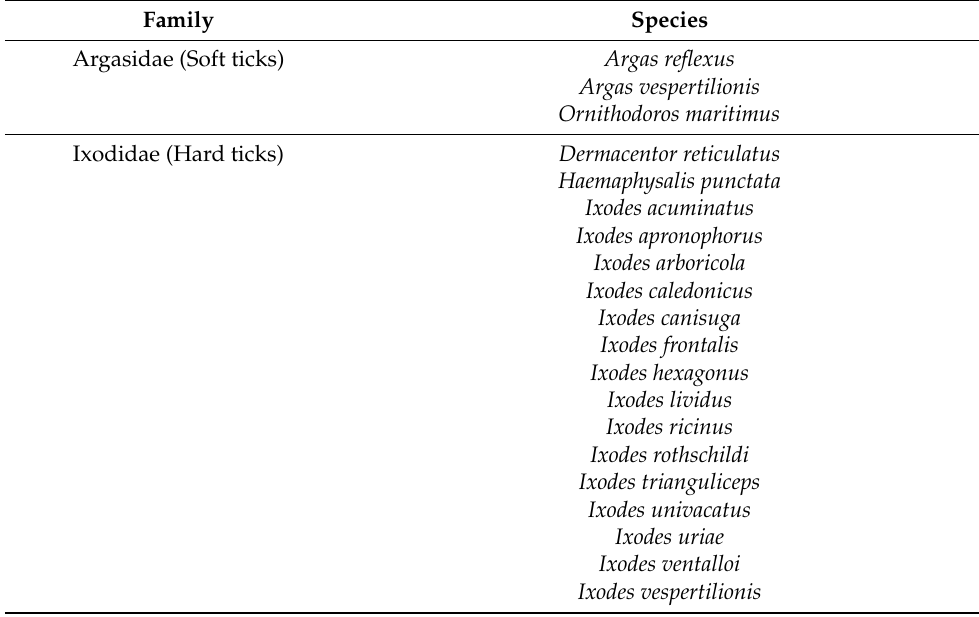
Table 2. The hard and soft tick species native to the United Kingdom.